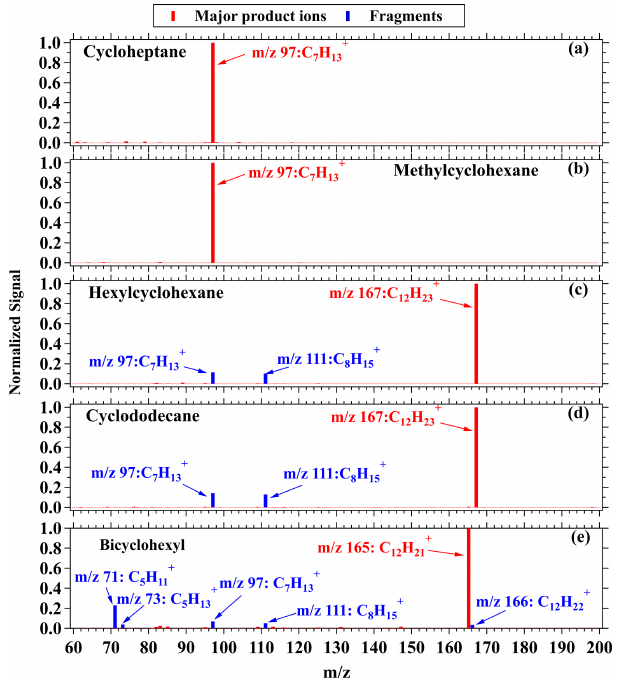
Figure 2. Mass spectra of product ions from cycloheptane (a) , methylcyclohexane (b) , hexylcyclohexane (c) , cyclododecane (d) , and bicyclohexyl (e) in NO + PTR-ToF-MS. The major product ions are shown in red, and the fragments are shown in blue.